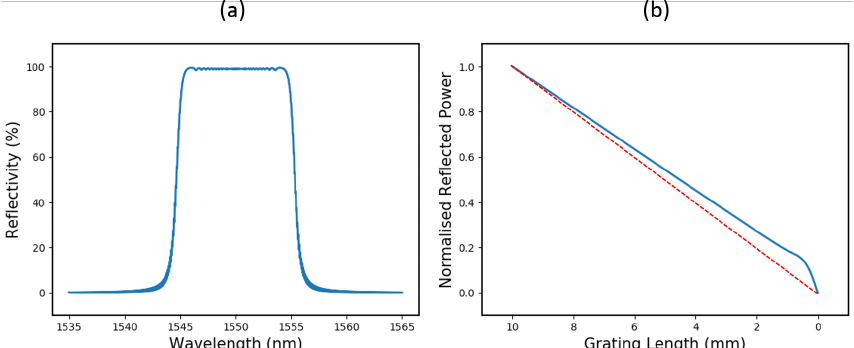
Figure 2. ( a ) The simulated reflection spectrum of a 10 mm, 99% reflectivity, 10 nm bandwidth, unapodised chirped grating; and ( b ) how the total reflected power reduces as the grating is destroyed. The power scales linearly until the final ∼ 1.5 mm, where it becomes non-linear. The dashed red line shows the ideal case, where reflected power is linearly proportional to grating